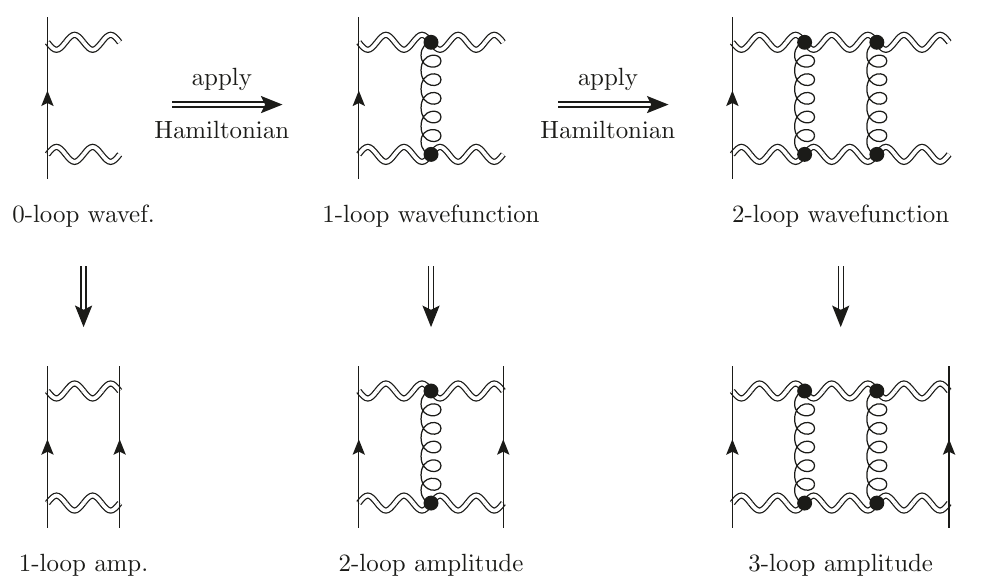
Figure 2 . Sketch of BFKL evolution generating ladder graphs in the imaginary part of the am- plitude. Considering initially emission from the projectile side only, the 0-loop wavefunction (top left) describes a state involving two reggeized gluons. The Reggeized gluons are both o(cid:11)-shell and are characterized by their transverse momenta k and p k . Each application of the BFKL Hamil- (cid:0) tonian (the top row) generates an additional rung in the ladder. Upon integrating the ( ‘ 1)-loop (cid:0) wavefunction with the target one obtains the ‘ -loop amplitude (bottom